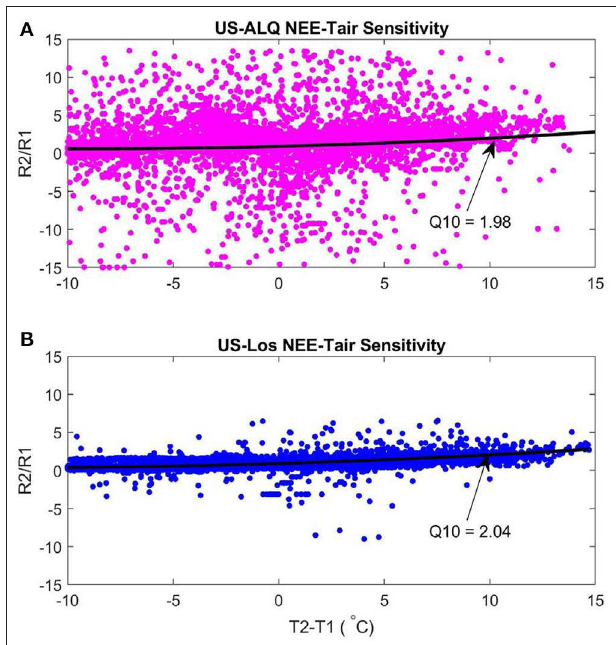
FIGURE 10 | Q 10 functions of nighttime NEE-air temperature sensitivity 2015–2017. Black line is the second-degree polynomial fit line. (A) Sheltered fen Q 10 . Root Mean Square Error: 5.17. (B) Open fen Q 10 . Root Mean Square Error: 5.13. Pink, sheltered fen (US-ALQ); blue, open fen (US-Los); black, second-degree